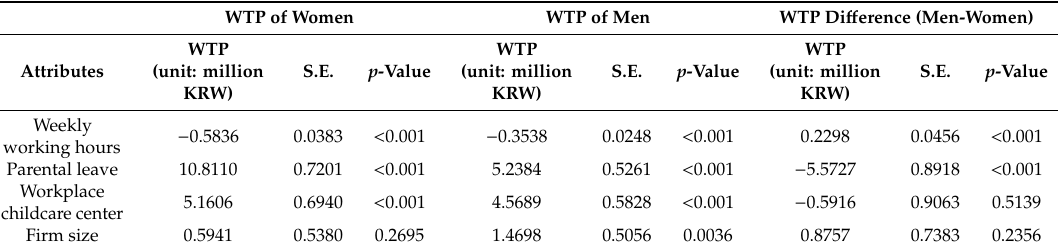
Table 8. WTP for workplace attributes, by